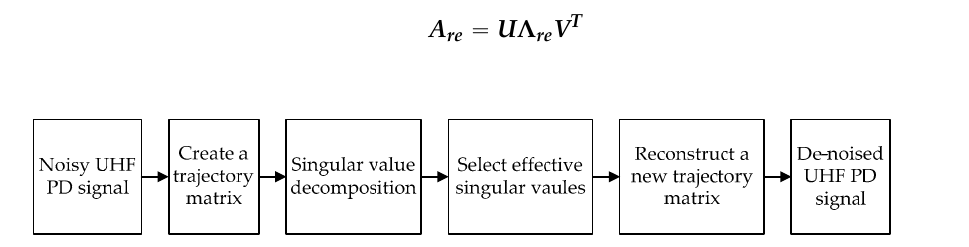
Figure 5. Procedure of the conventional SVD de-noising method.